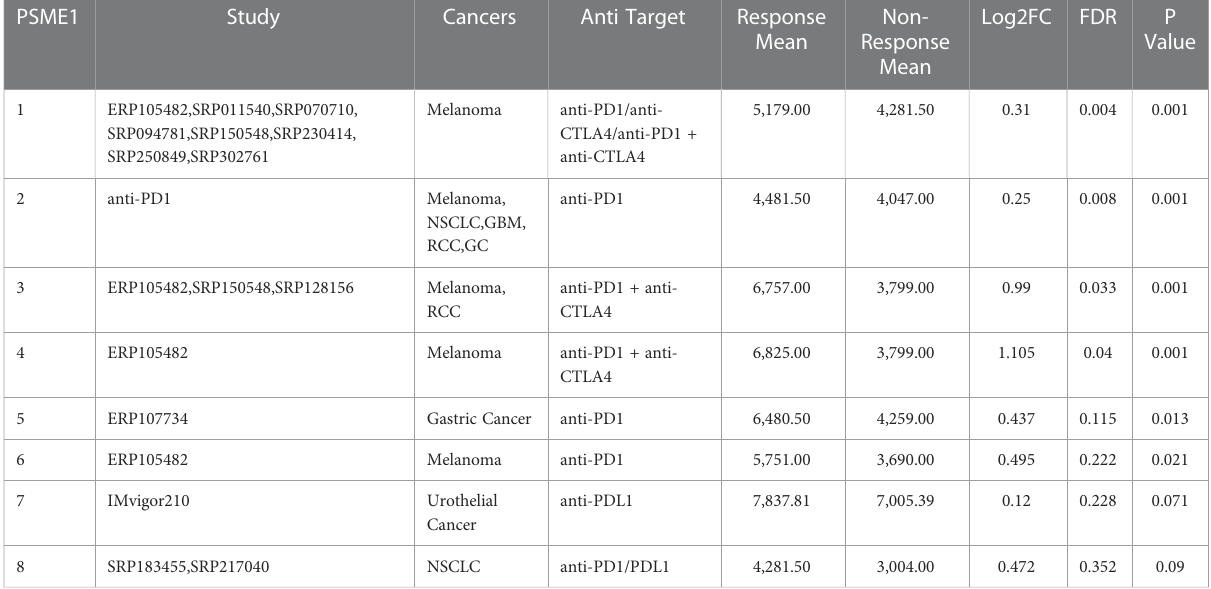
TABLE 4 PSME1 expression distribution for response and non-response based on pre-treatment samples in all datasets. PSME1